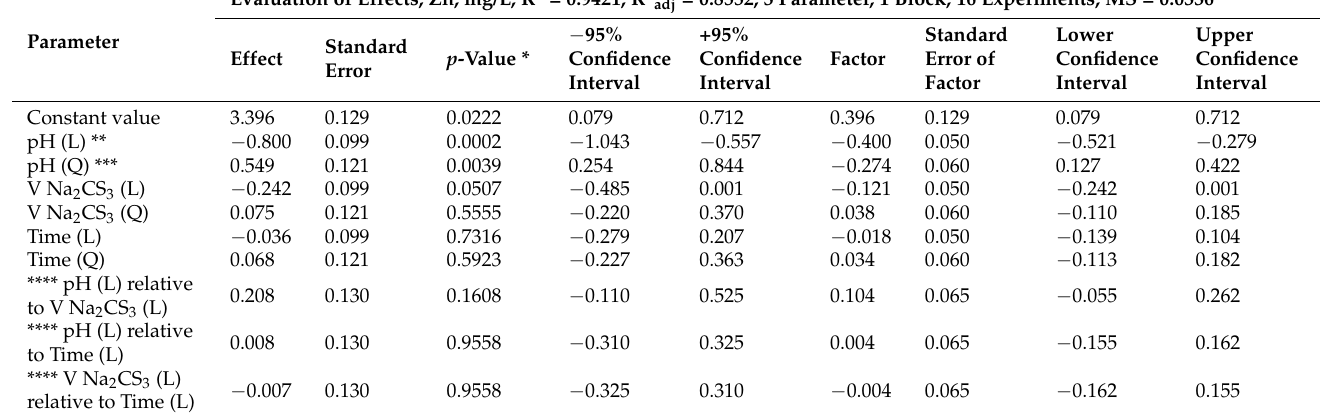
Table 4. Analysis of the experiments findings—the initial assessment of the effects by Statistica 13.